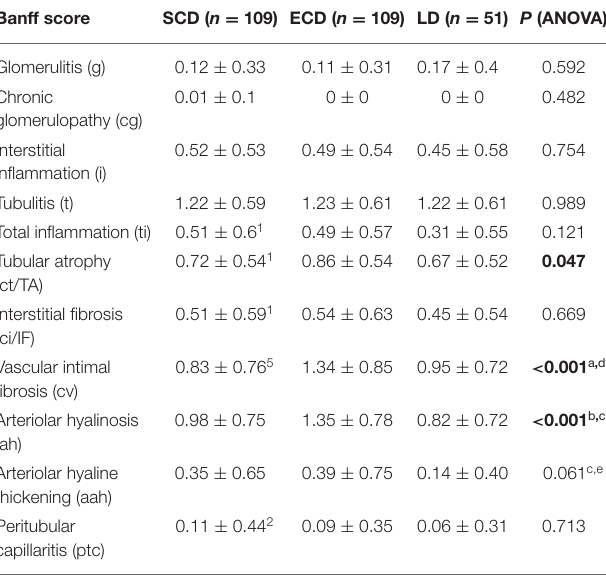
TABLE 2 | Histological findings in indication biopsies with BL performed early after transplantation stratified according to donor type. Banff